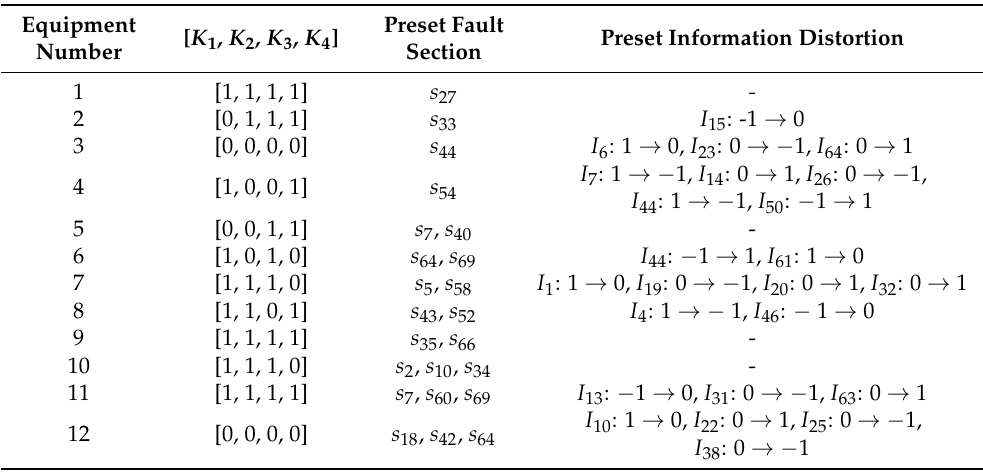
Table 7. Test cases for IEEE 69-node distribution network.